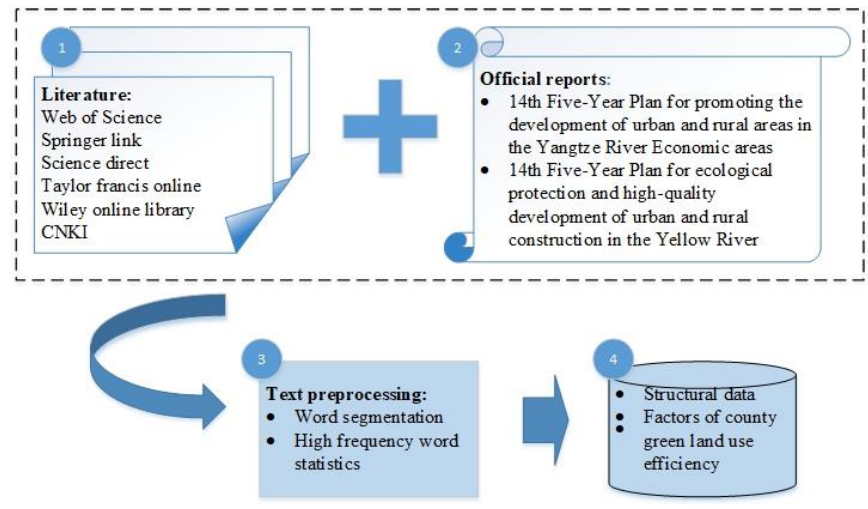
Figure 2. Basic operation principles of ROST content mining.